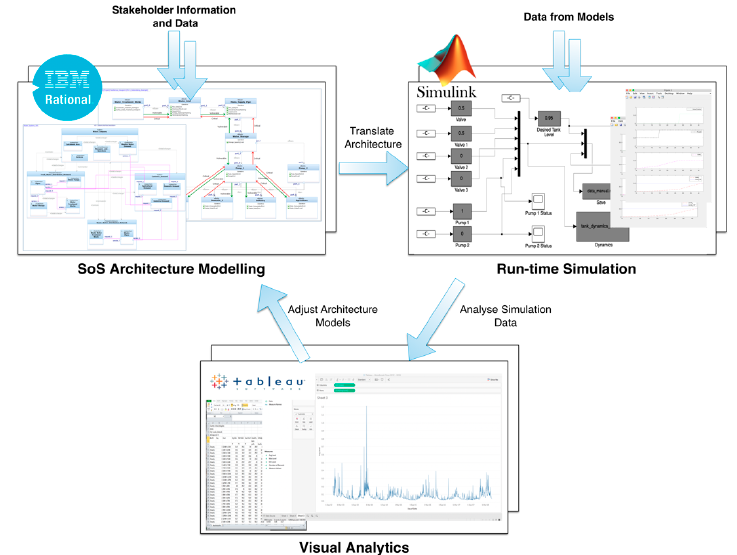
Figure 5. Modelling and simulation workflow.